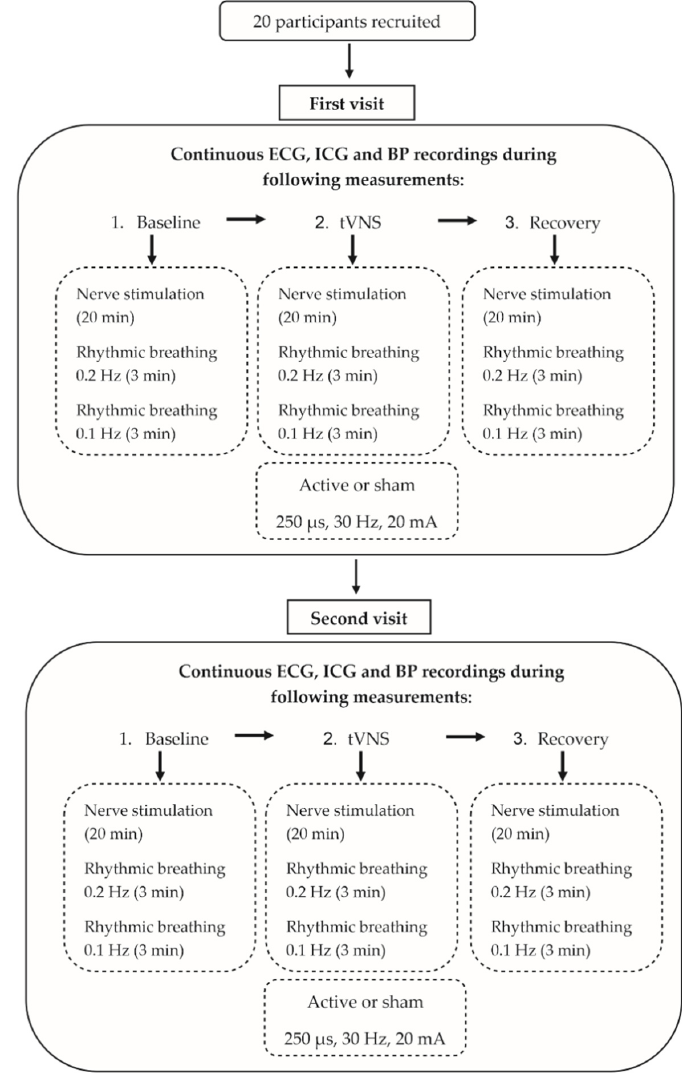
Figure 1. Experimental protocol